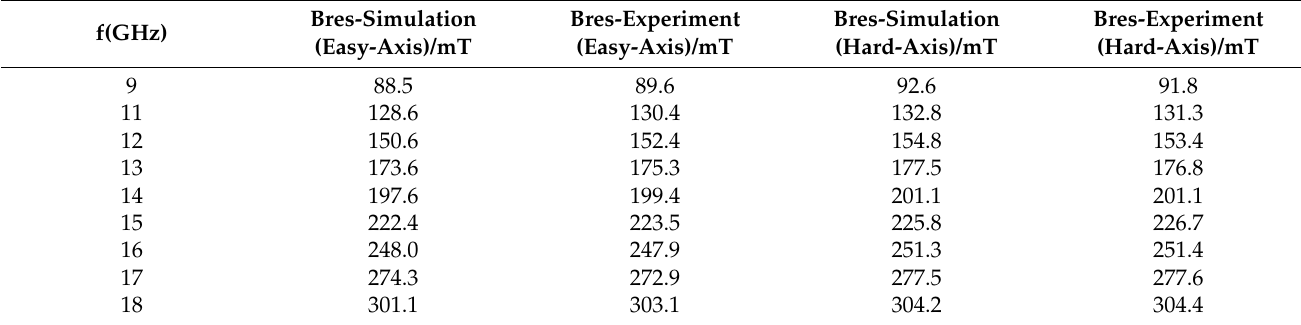
Table 2. Comparison of the resonance field values from experiment and simulation of Py strip for both axis at selected frequencies. Resonance field values are given in mT for both